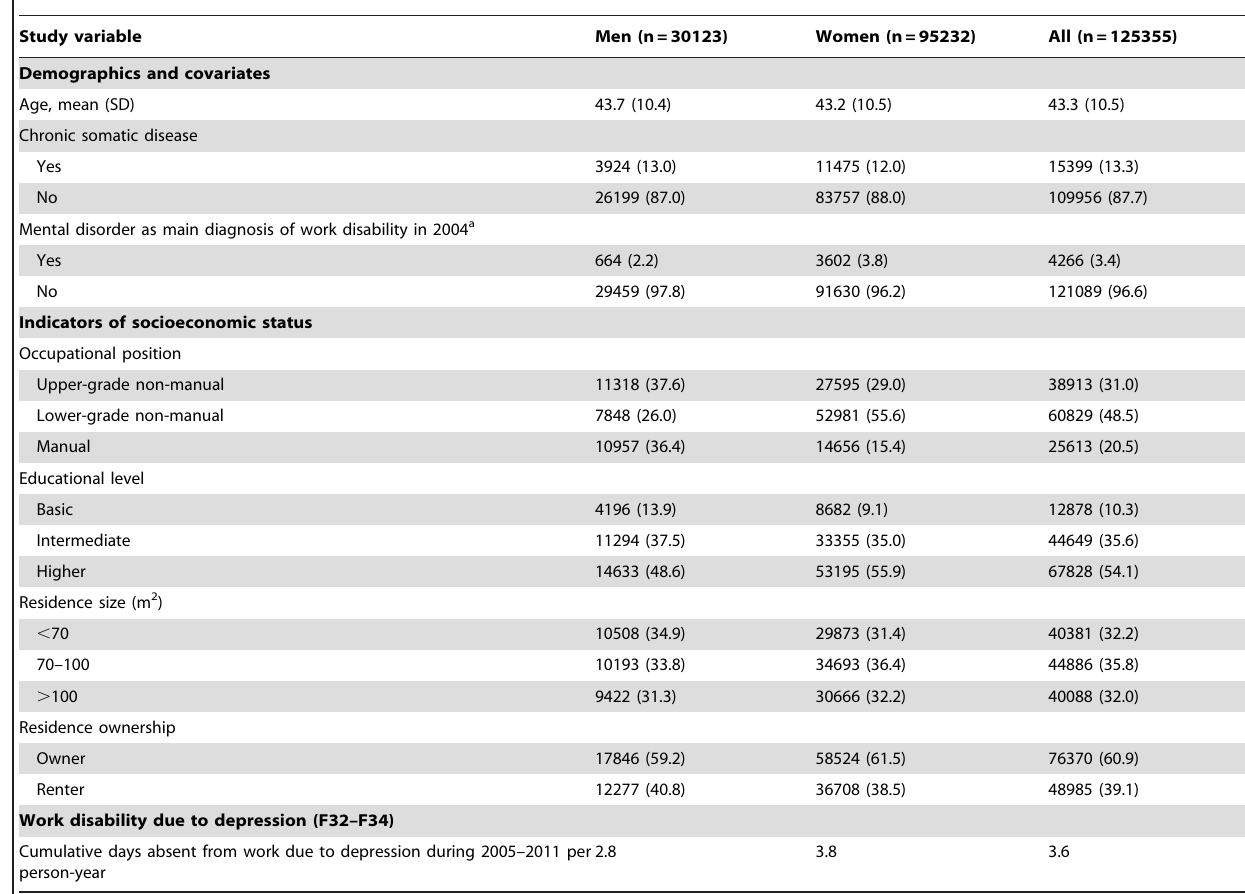
Table 1. Characteristics of study